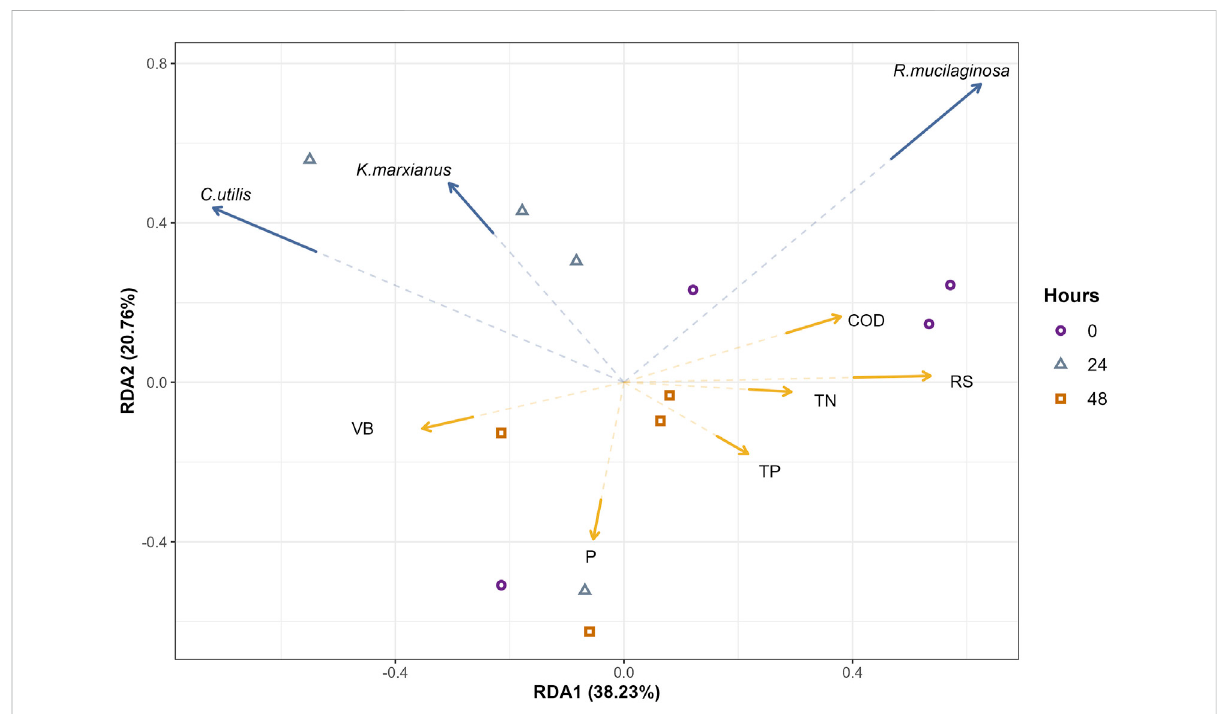
FIGURE 2 Redundancy analysis (RDA) showing correlations between yeast and physicochemical parameters. Yellow vectors represent the physicochemical parameters and blue vectors represent yeast